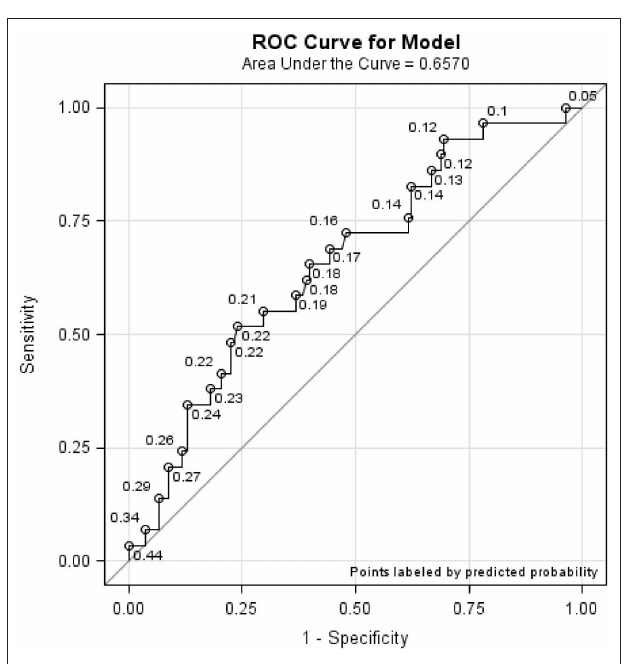
FIGURE 5 | ROC curve demonstrating predictive validity of the two-level Quick-STEADI algorithm for fall risk, adjusted for age, sex, and education.